Question: Write a single sentence explaining what this figure depicts.
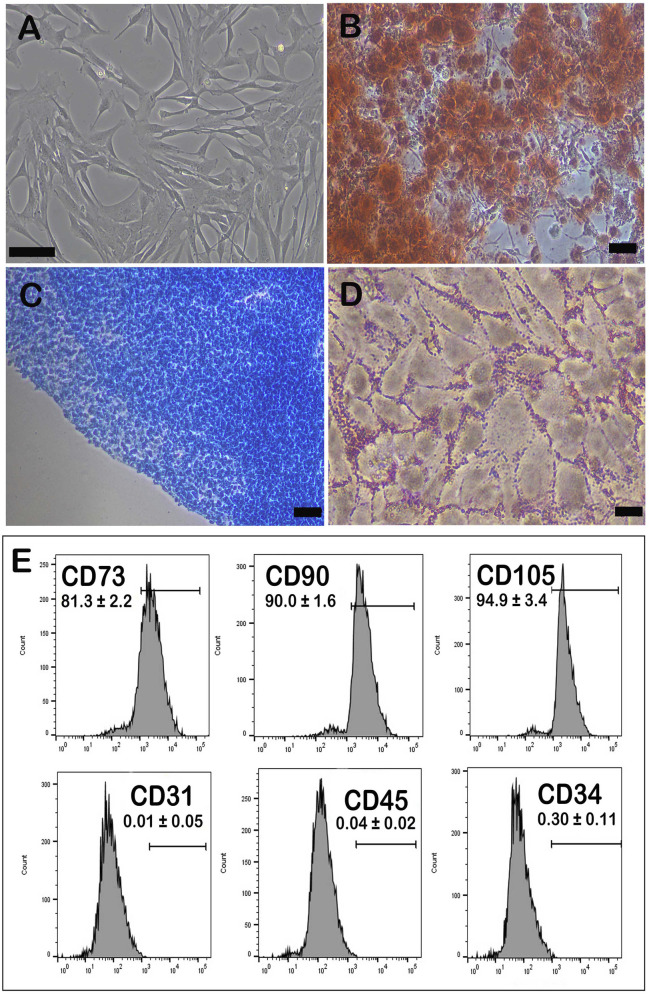
Answer: Isolation, differentiation, and immunophenotypic characterisation of gADSCs. (A) Phase-contrast image of sub-confluent goat adipose tissue-derived mesenchymal stem cells (gADSCs) at passage 4, showing typical fibroblast-like/spindle-shaped mesenchymal morphology. Trilineage differentiation potential of gADSCs was confirmed by lineage-specific staining: (B) osteogenic differentiation showing calcium deposition by Alizarin Red staining; (C) chondrogenic differentiation showing glycosaminoglycan-rich matrix by Alcian Blue staining; and (D) adipogenic differentiation showing intracellular lipid accumulation by Oil Red O staining. (E) Flow cytometric immunophenotyping of gADSCs showing high expression of mesenchymal stromal cell-associated markers CD73, CD90, and CD105, and minimal expression of hematopoietic/endothelial markers CD31, CD45, and CD34. Solid histograms represent marker-specific staining. Data shown for surface-marker expression represent mean percentage ±SEM from gADSCs derived from three independent donors and analysed between passages P6–P9. Scale bar = 40 µm.